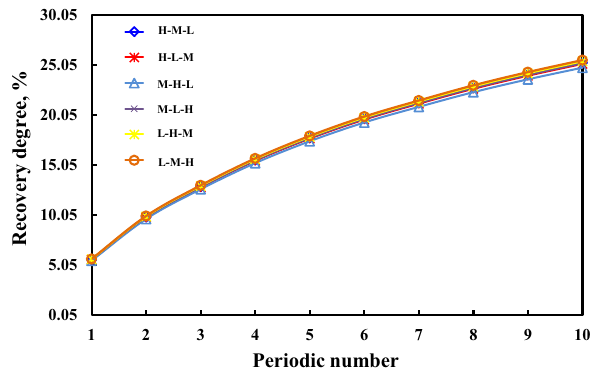
Fig. 4 The effect of permeability distribution pattern on the recovery degree